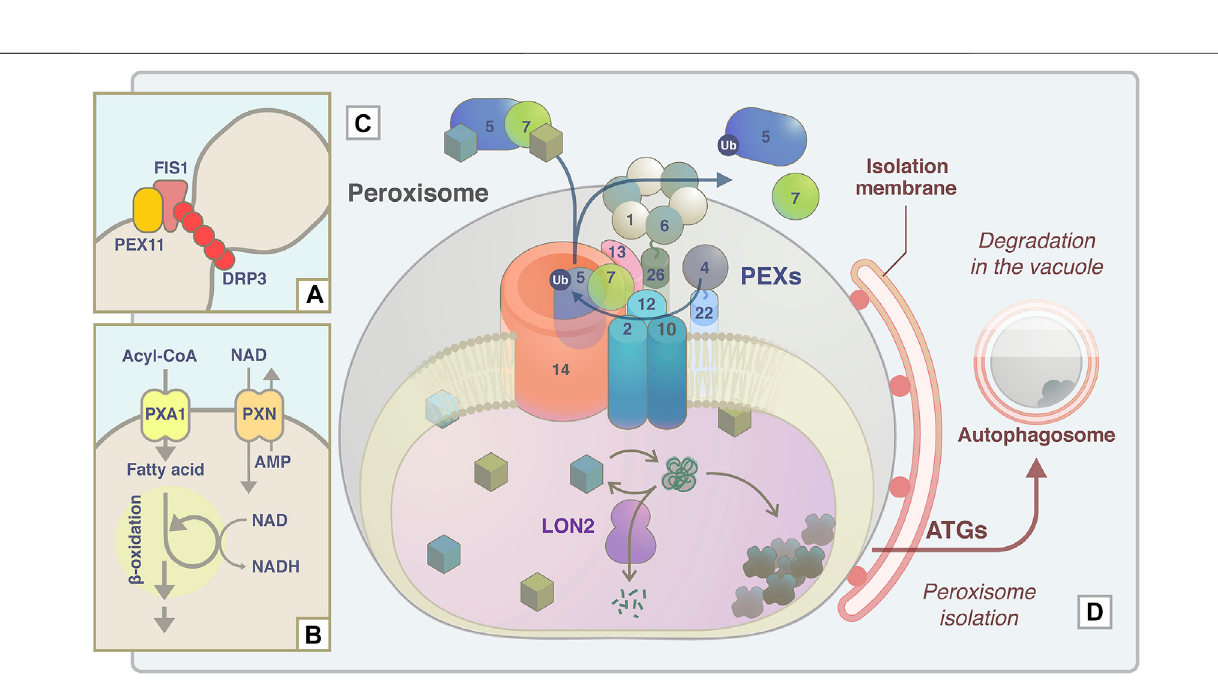
Figure 4 . APEM1/DRP3A was identi fi ed as a major component of the peroxisome division machinery. APEM2/PEX13, APEM4/ PEX12, and APEM9/PEX15/PEX26 were identi fi ed as a group of peroxisome biogenesis factors. Like in animals, many plant PEX mutants with T-DNA insertions causing complete protein dysfunction display lethality, as reported in studies of PEX2,